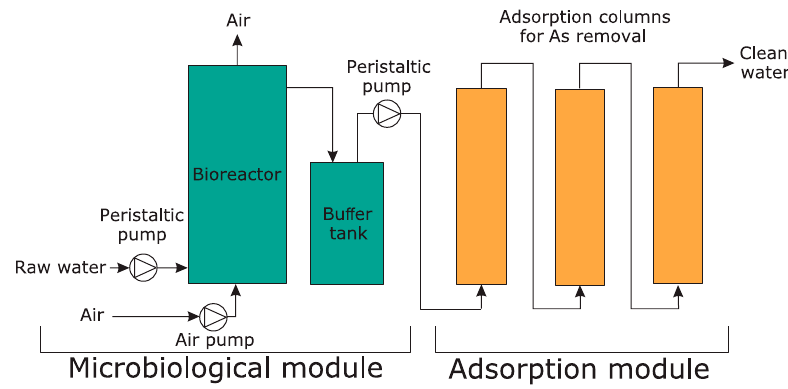
Figure 1. The pilot-scale installation used for remediation of arsenic contaminated water. The image is a schematic representation of the pilot-scale installation developed as part of this work. Both the microbiological and adsorption modules are shown.